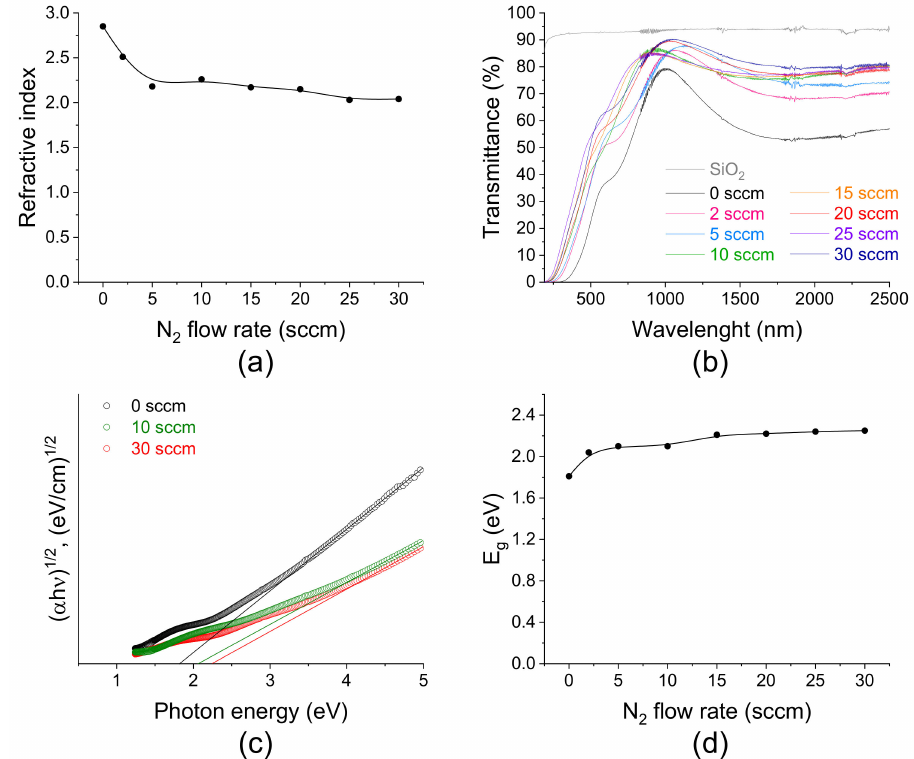
Figure 8. Optical properties of SiC x N y films deposited at various nitrogen flow rates (series A): ( a ) refractive index, ( b ) transmittance, ( c ) Tauc plots versus photon energy with linear approximation and ( d ) band gap